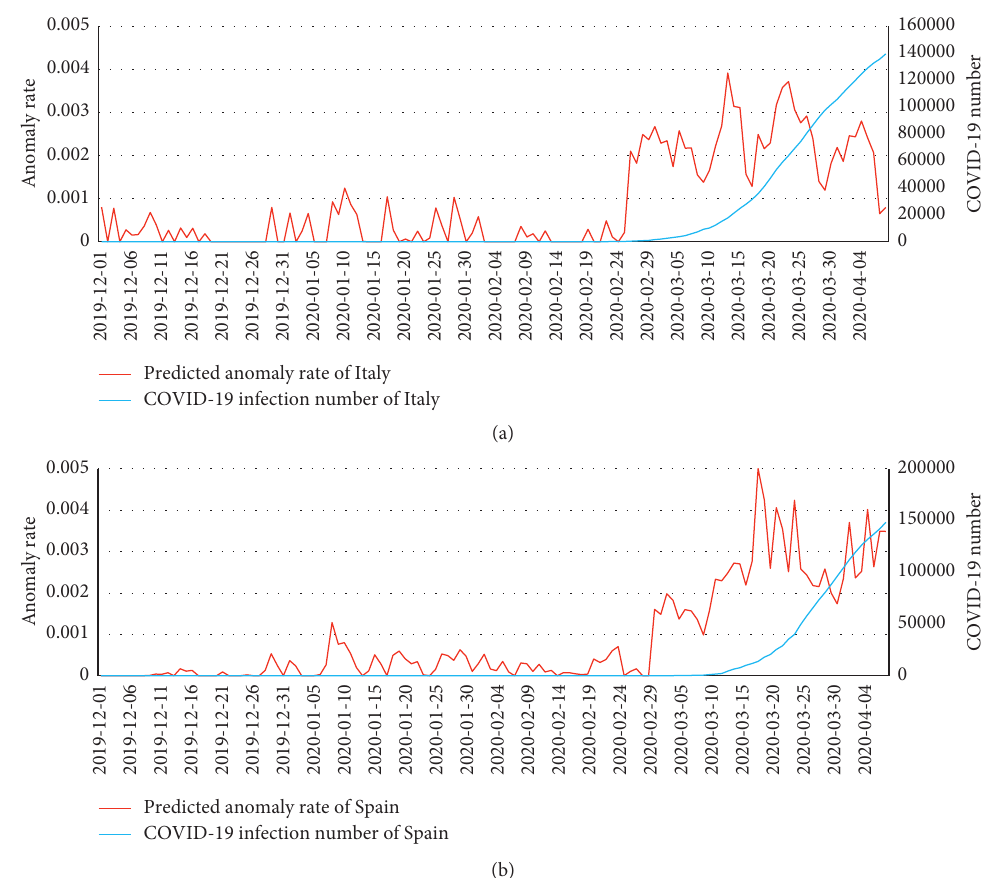
Figure 6: Predicted COVID-19 anomaly rate and the officially reported accumulating COVID-19 infection number of (a) Italy and (b) Spain.